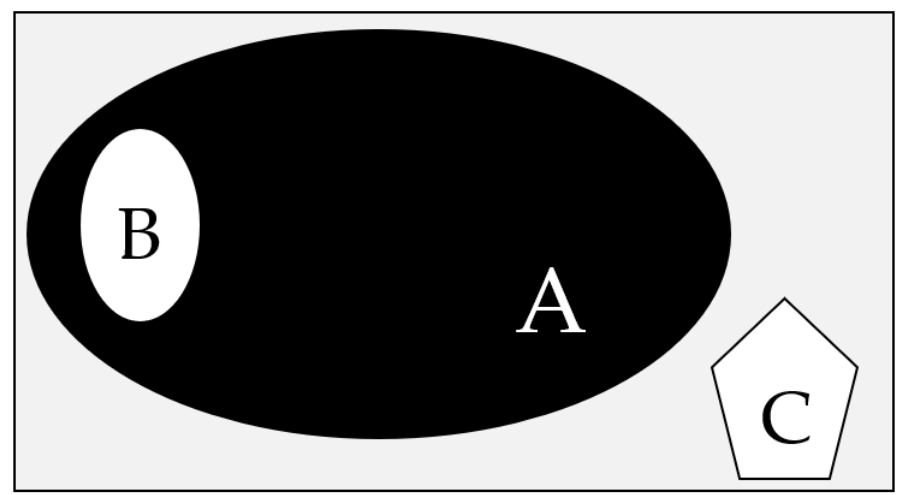
Figure 3. Chart on biodegradable vs. compostable vs. oxo-degradable plastic categories: ( A ) biodegradable, ( B ) compostable and ( C ) oxo-degradable. Data adapted from [36].